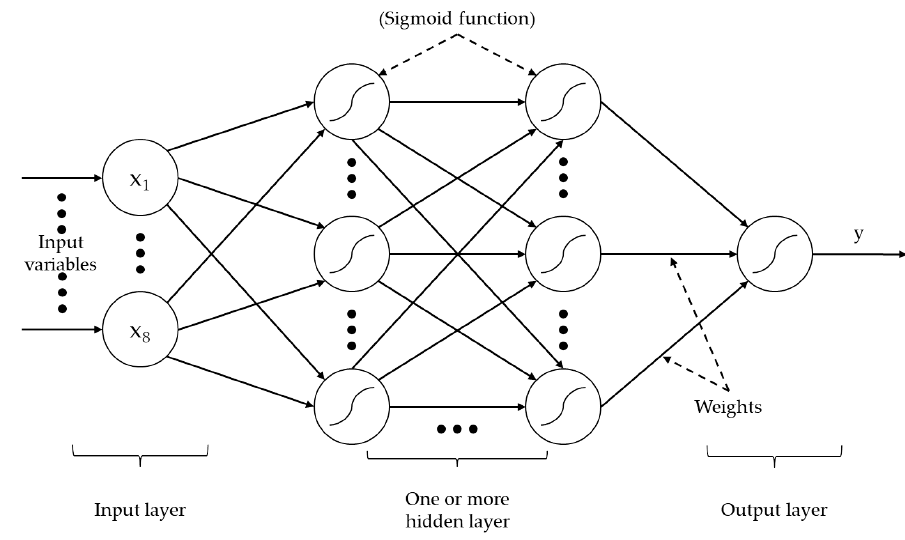
Figure 9. Architecture of a multi-layer neural